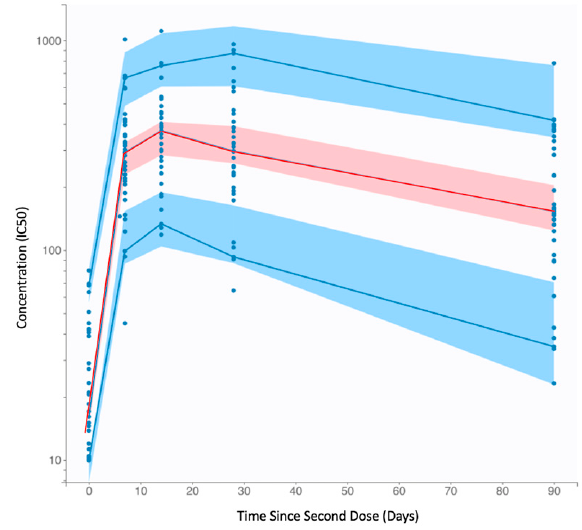
Figure 1. Visual predictive check (VPC) of nAb kinetics model fit with the 90% prediction intervals. The blue dots represent the observed clinical nAb kinetics data [4]. The red line represents the empirical 50th percentile and the blue lines represent the empirical 10th and 90th percentiles. The shaded regions represent the model’s 90% prediction intervals for the 50th percentile (pink) and 10th and 90th percentiles (blue). The empirical percentiles fall within the model’s prediction intervals, indicating good model agreement with the data. Table 1. Parameter values for fi tt ed nAb kinetics model with standard errors (SE) and relative stand- ard error (RSE).